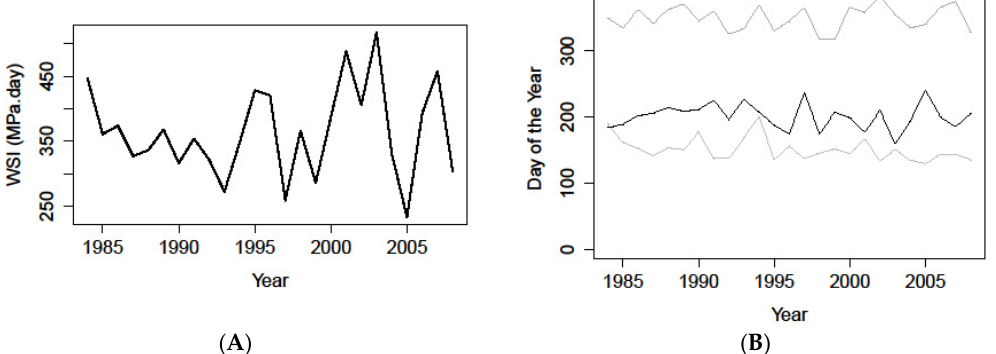
Figure 8. ( A ) Yearly water stress integral (WSI MPa) simulated from the daily soil water budget and predawn water potentials for the 1985–2008 period simulated with a field capacity of 890 mm; ( B ) Yearly growing season start t 0 (lower grey line), drought onset t 1 (black line), and drought offset t 2 (upper grey line), respectively, simulated from winter temperatures from January to March, and the daily water budget for the 1985–2008 period simulated with a field capacity of 890 mm.